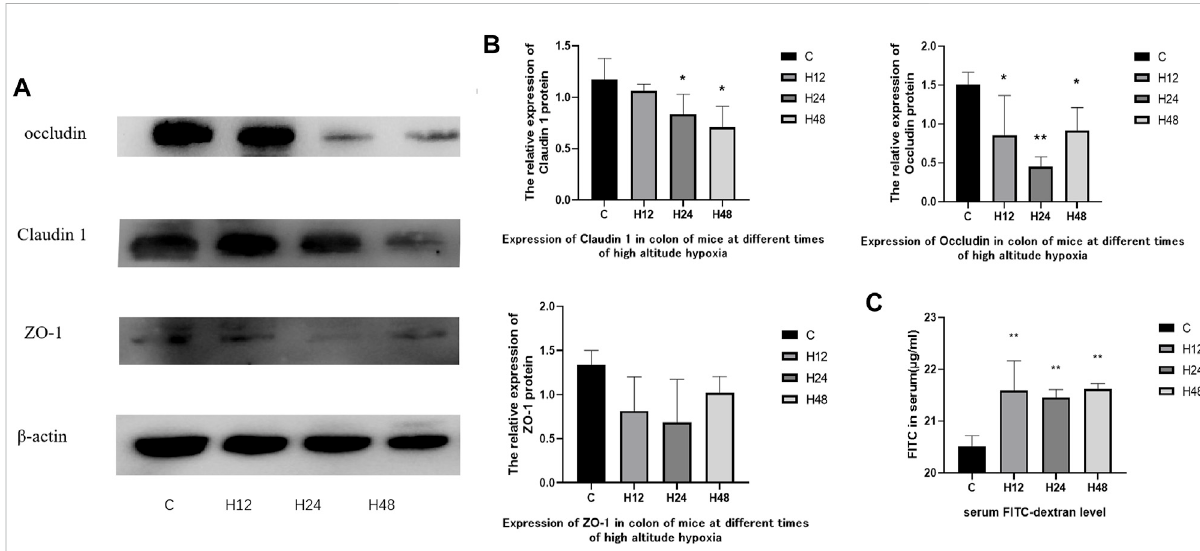
FIGURE 2 (A,B) Expression of tight junction protein in colon tissues of mice in each group, n = 3. (C) Serum FITC-dextran level, n = 5. C, control group; H12 group, the high-altitude group for 12 h; H24 group, the high-altitude group for 24 h; H48, the high-altitude group for 48 h. The data are presented as the mean ± standard error of the mean. * p < 0.05 vs . N group, ** p < 0.01 vs . C group.